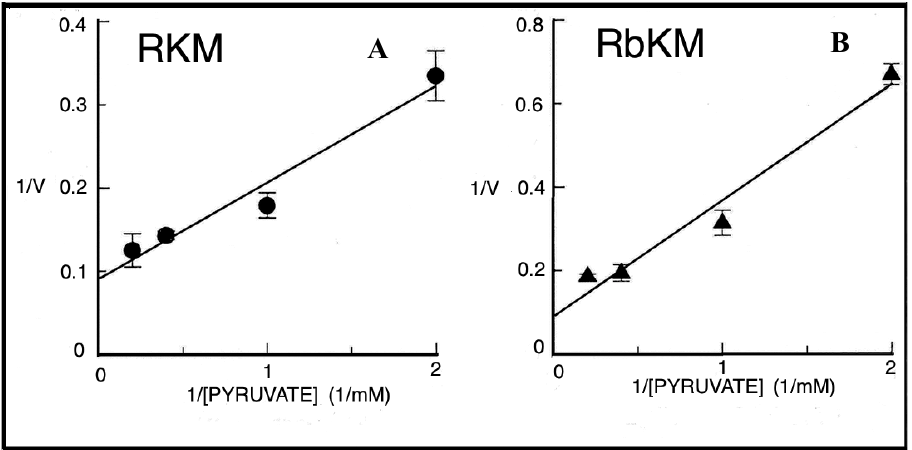
Figure 9. The dependence of the rate of the pyruvate/[ 14 C]-phosphoenolpyruvate (PEP) exchanges in either rat ( A ) or rabbit ( B ) kidney mitochondria on the external pyruvate concentration. From [12]. With permission from Aracne Editrice, 2021. [ 14 C]-PEP-loaded mitochondria (1 mg protein) were incubated at 4 °C in 1 mL of a standard medium consisting of 15 mM KCl, 1 mM MgCl2, 100 mM TRIS-HCl, pH 7.4 plus 1 μ g of μ g rotenone, 3 μ g oligomycin in the presence of 5 mM arsenite and 10 mM oxalate. After 1 min incubation, the assay was started with pyruvate, at the concentrations indicated, and was stopped after 6 seconds by the addition of 10 mM phenylsuccinate. The exported 14 C-PEP was assayed as reported above. Both RKM and RBKM were loaded with 14 C-PEP and its efflux measured according to the stop inhibitor method.